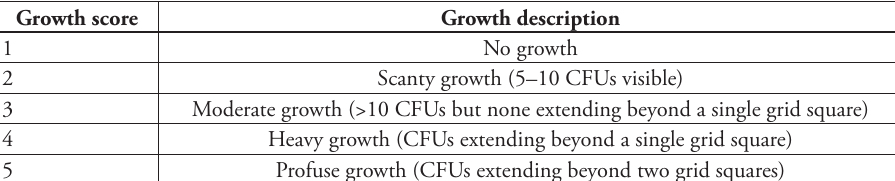
Table 1. Description of used growth scores on sample contact plates. CFUs = colony forming units. Growth